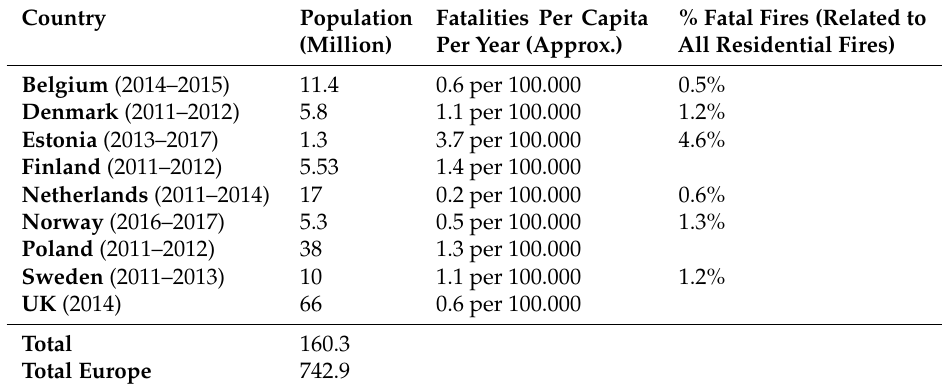
Figure 1. Distribution of fires by types. International Association of Fire and Rescue Services by Center of Fire Statistics of CTIF 2018 [1]. Table 1. Population, fatalities per capita per year and percentage of fatal fires in selected European countries